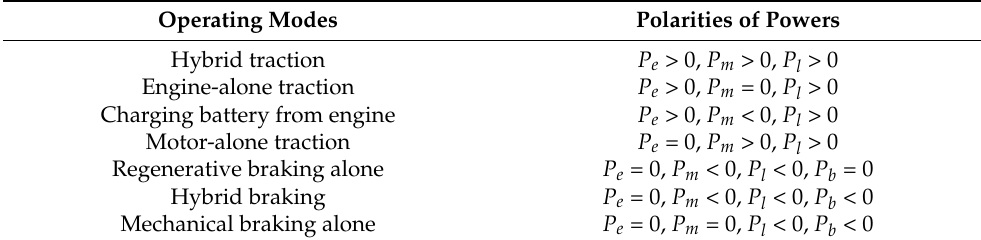
Figure 3. Optimal engine operating points overlapping the fuel consumption map [1,2] under various operating modes during the FTP75 Highway driving cycle for hybridization of Toyota Corolla 2019 with three P m_rated values: ( a ) P m_rated = 0 kW; ( b ) P m_rated = 10 kW; ( c ) P m_rated = 30 kW. Table 5. Polarities of powers of motor, engine and load in each operating